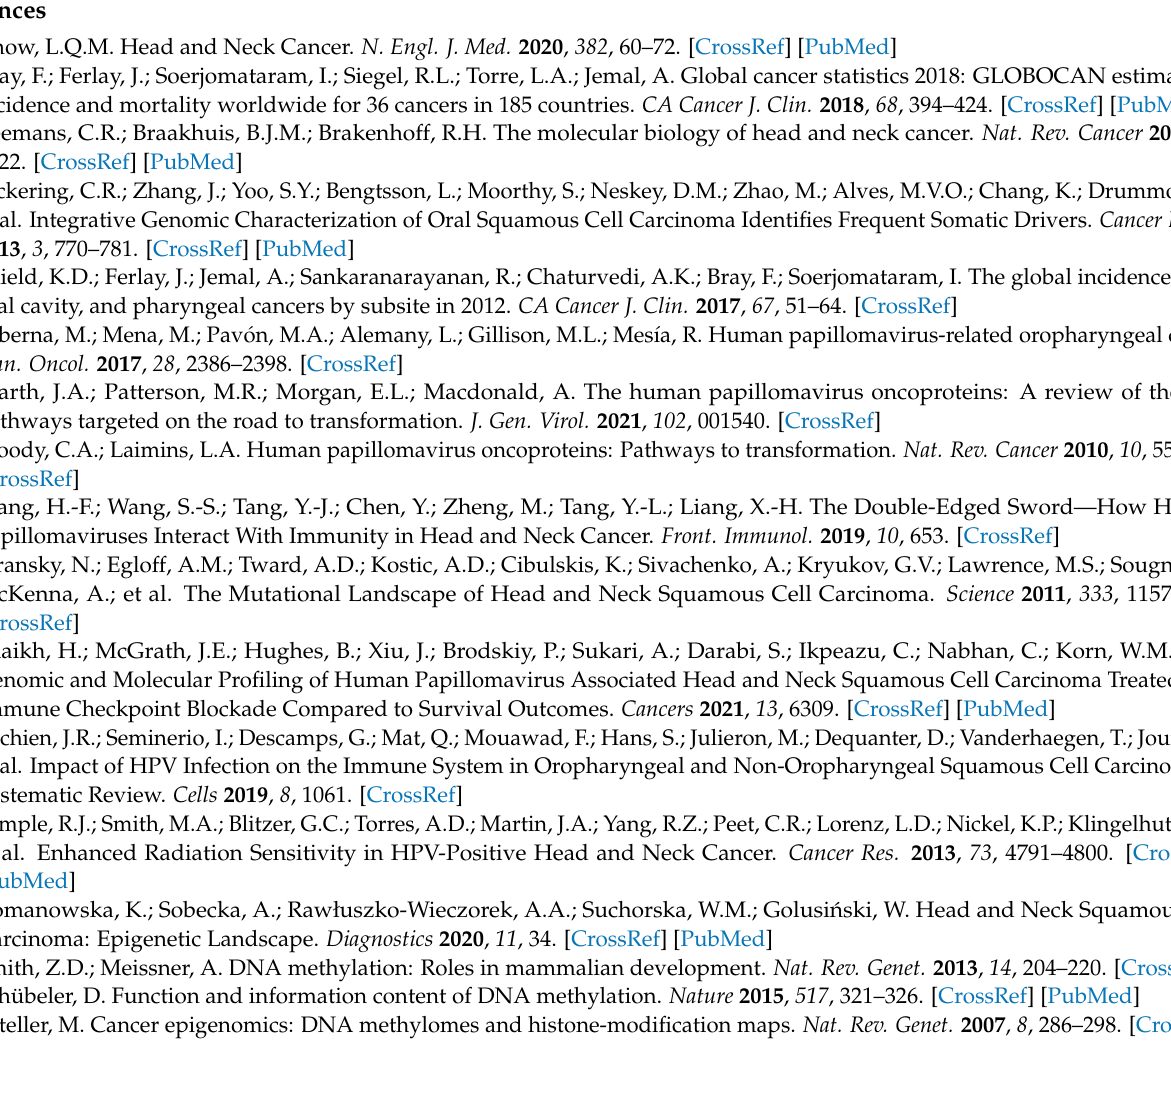
array, Table S5: Primers of genes for qRT-PCR, Table S6: SiRNA sequences of genes, File S1: Original Western